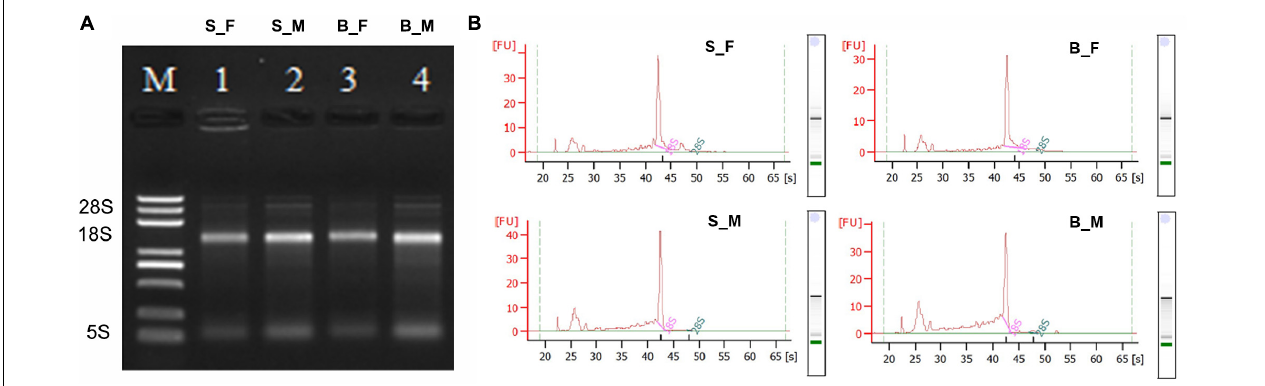
FIGURE 1 | Qualitative and quantitative integrity identification of the total RNA of the Schistosoma japonicum worm samples. (A) Qualitative integrity identification of the total RNA of the S. japonicum worm samples by denatured agarose gel electrophoresis. Of the total RNA from each sample, 3 µ l was loaded on 1.2% denaturing agarose gel with ethidium bromide (EB). The voltage of the electrophoresis was 65 V. The gel was observed and photographed with an ultraviolet transmission analyzer after the electrophoresis was finished. The 28S rRNA bands are absent, the 18S rRNA bands are present as the main bands with appropriate peaks, and the second bands are the weaker 5S bands. Therefore, the in vivo nick of the L-rRNA of S. japonicum worms total RNA was observed and confirmed here, which indicated good integrity of the total RNA of the S. japonicum worm samples in this study. M : RNA ladder. 1 : S_F; 2 : S_M; 3 : B_F; 4 : B_M. (B) Quantitative integrity identification of the total RNA of the S. japonicum worm samples by an Agilent 2100 Bioanalyzer. The peaks of 28S rRNA are also absent and the peaks of 18S rRNA are present as the main peaks for all four samples. Therefore, the in vivo nick of the L-rRNA in S. japonicum worms total RNA was also observed and confirmed here, which further indicated the good integrity and purity of the total RNA of the S. japonicum worm samples used here. B_F female worms from BALB/c mice, B_M male worms from BALB/c mice, S_F female worms from SCID mice, S_M male worms from SCID mice.